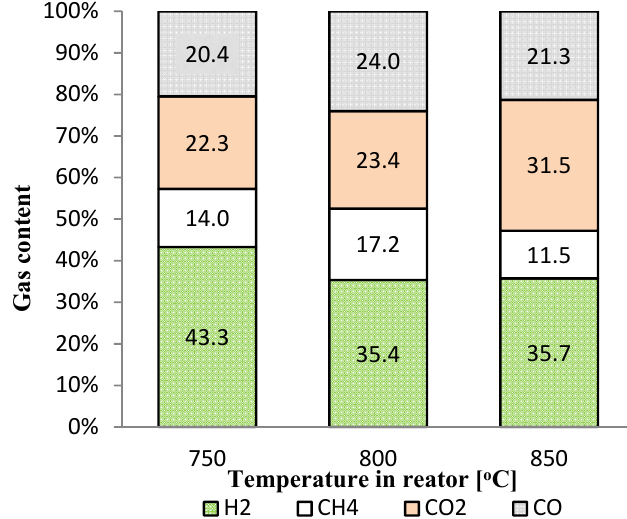
Figure 4. Impact of the temperature in the reactor on the composition of the generated gas (the least significant di ff erence at a significance level p < 0.05 for H 2 = 1.0%, CH 4 = 0.4%, CO 2 = 0.8%, CO = 1.5%).